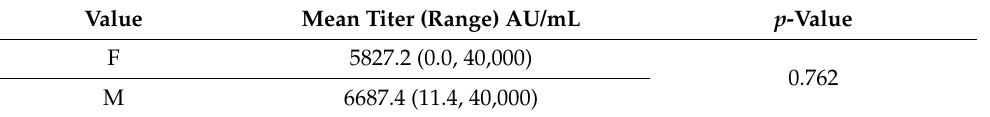
Table 2. Mean titer (range) AU/mL for anti-SARS-CoV2 neutralizing IgG antibodies in vaccinated HCWs for males and